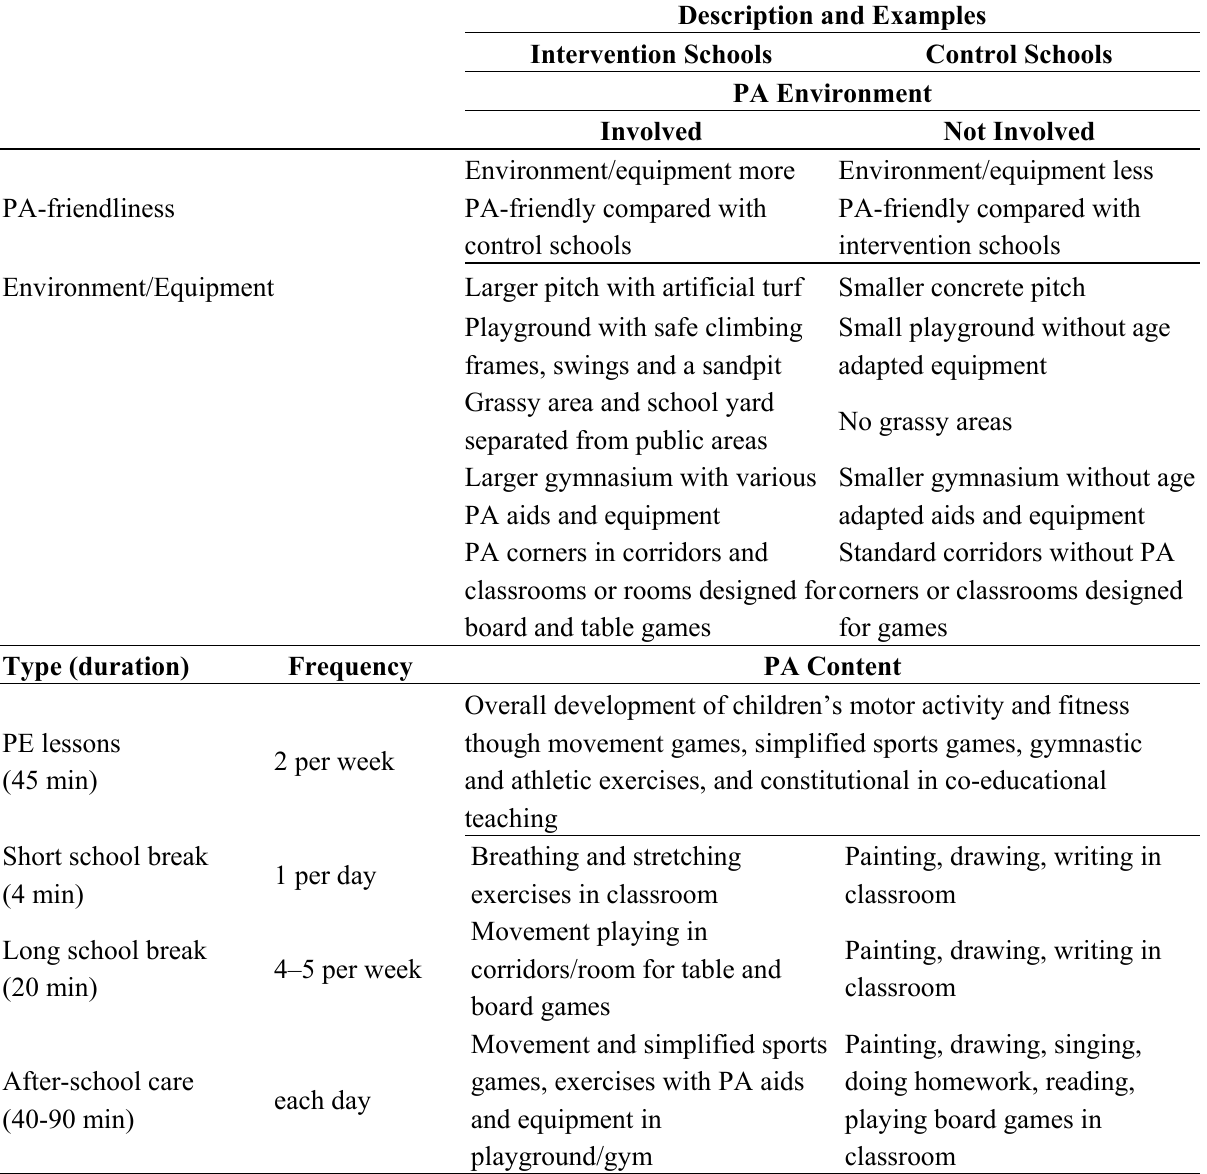
Table 2. PA Environment and school day PA content of intervention and control schools during two years